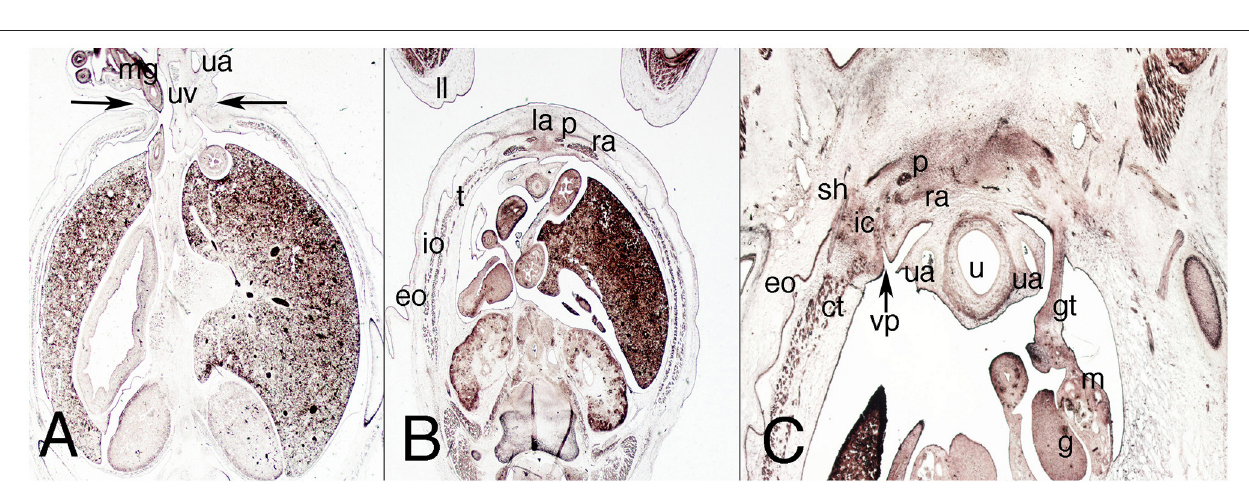
FIGURE 8 | Transverse sections of the female fetus VD-34 (nine weeks) cranial to caudal. H-E, Azan and VOF staining. (A) (1x) level of the umbilical hernia; (B) (1x) section at middle third of the abdomen; (C) (1X) at the inferior third of the abdomen, inguinal region. ct, common tendon; eo, external oblique muscle; g, gonad; gt, gubernaculum testis; ic, inguinal canal; io, internal oblique muscle; la, linea alba; m, mesonephros; mg, middle gut; p, pyramidalis muscle; ra, rectus abdominis; sh, subcutaneous hole; u, urachu; ua, umbilical artery; uv, umbilical vein; vp, vaginal process. Arrows, neck of the umbilical